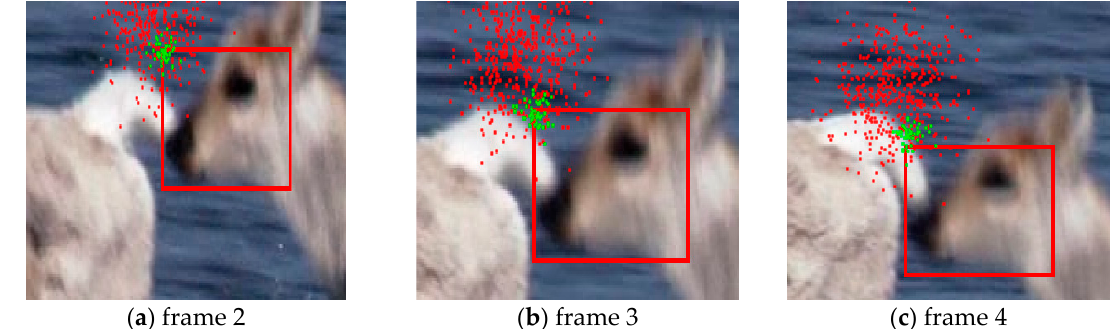
Figure 1. The details of particles put in the third frame of the Deer sequence. All of the particles are divided into two parts and put separately, the red particles indicate the particles put for the first time, and the green particles indicate the particles put for the second time, and the location of the particle is assumed to correspond to the upper left corner of the tracked bounding box. Firstly, the first part particles (red particles) are put according to the target state of the second frame, and the locations of these particles are in accordance with the Gaussian distribution. Then, the similarity of each red particle to the template is calculated, and the second part particles (green particles) are put at the location of the red particle with the highest similarity, and the locations of the green particles are still in accordance with the Gaussian distribution. Finally, the similarity of each green particle is calculated, and the most similar particle (including red and green particles) is selected as the candidate target. When the particles are put in the fourth frame, the same method as the third frame is utilized. It can be seen that the most similar red particle has been close to the target, and then using the green particles to cover the target, which can make the number of the particles that are distributed around the target as many as possible.